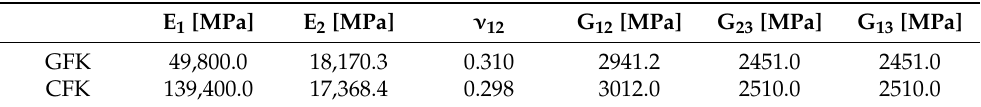
Table 3. Mechanical properties: GFRP and CFRP